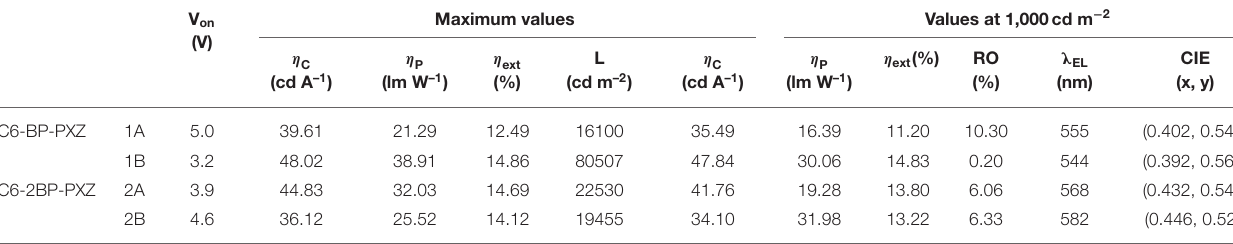
TABLE 2 | EL performances of OLEDs based on FC6-BP-PXZ and FC6-2BP-PXZ a . V on